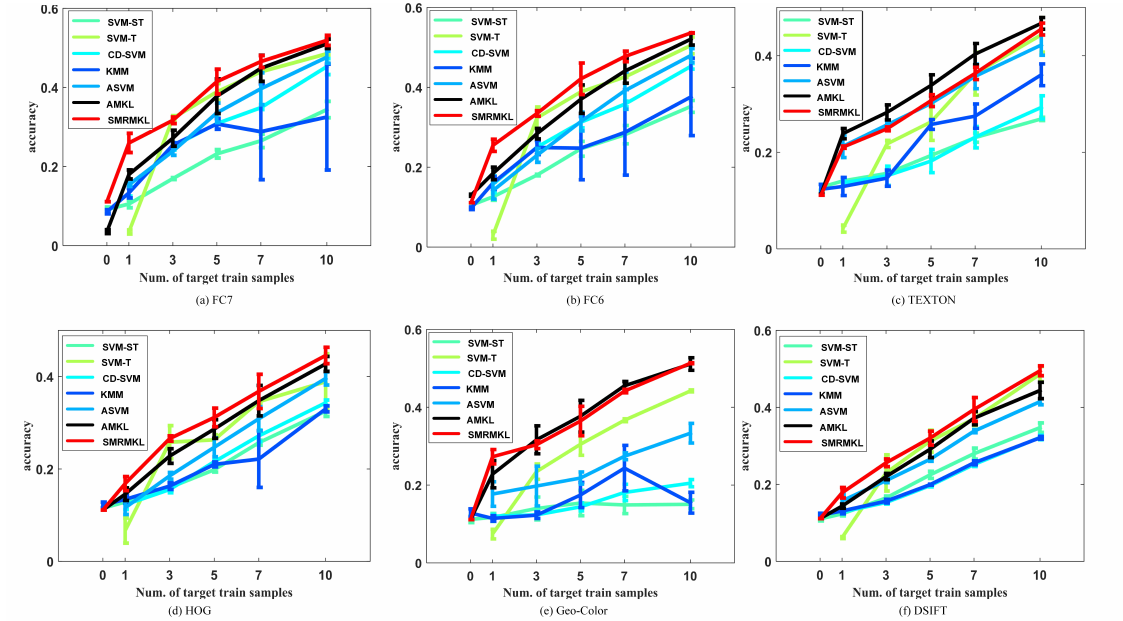
Figure 11. The performance (mean and standard deviation of overall accuracy) of different approaches using different features with respect to different numbers of target samples per class for the aerial-to-satellite transfer